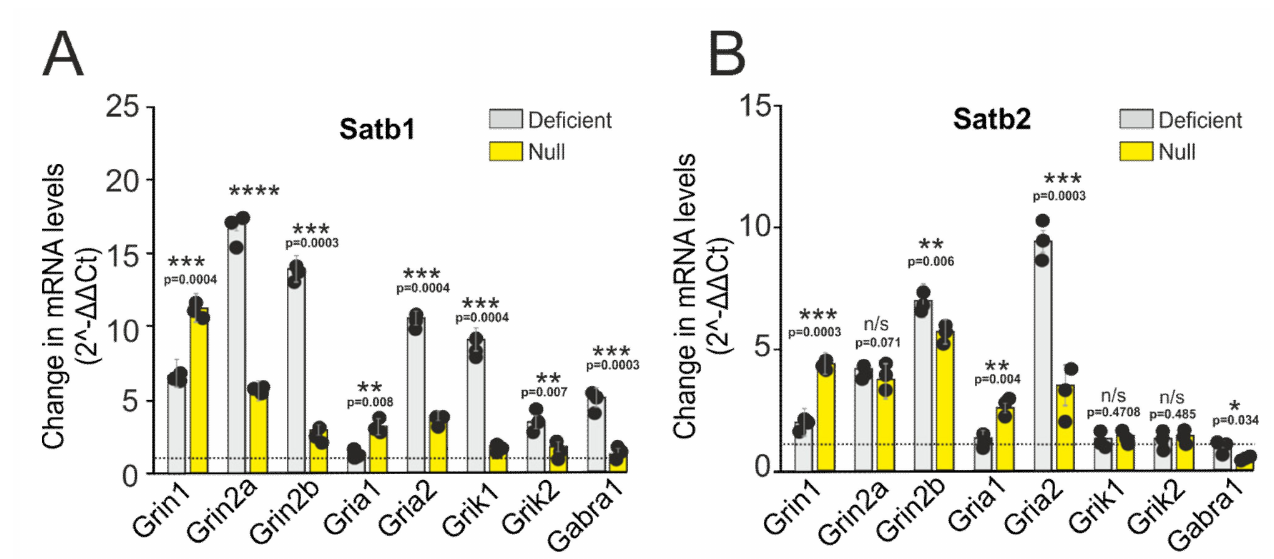
Figure 2. Deletion in Satb1 and Satb2 affects the expression of genes, encoding subunits of excitatory and inhibitory neurotransmitters produced by the cortical cell cultures. ( A , B )—alteration in the expression of genes, encoding subunits of NMDAR (Grin1, Grin2a, Grin2b), AMPAR (Gria1, Gria2), KAR (Grik1, Grik2) and GABA(A)R (Gabra1) in the cortical neurons in Satb-deficient and Satb-null mice with deletions of transcription factors Satb1 ( A ) and Satb2 ( B ). Data obtained on four ( n = 3) different cell cultures are presented. All values are given as mean ± SEM. Gene expression level was normalized to reference gene Gapdh and was presented relating control (neurons from Satb +/+ * Nex Cre/+ -mice), which was considered as 1 (dashed line). Total RNA was obtained from 10 DIV cultures. Statistical analyses were performed by paired t-test. Comparison of gene expression was performed between Satb-deficient and Satb-null mice. The data were significant: n/s—data not significant ( p > 0.05); * p < 0.05; ** p < 0.01; *** p < 0.001 and **** p <